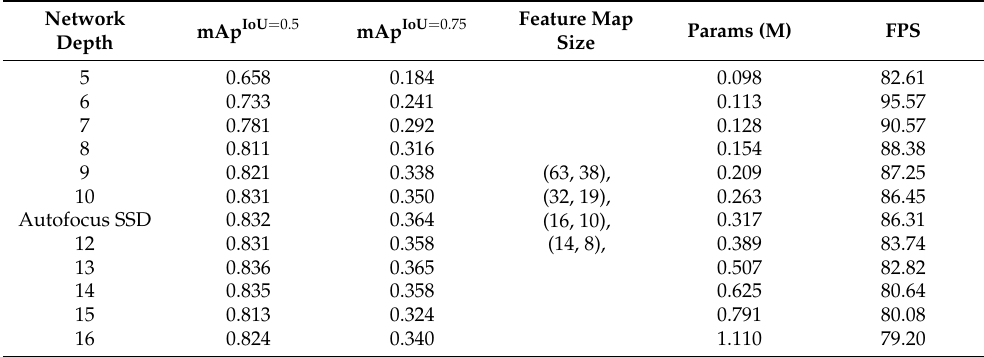
Table 6. Relationship between depth and Autofocus SSD prediction performance in Modified Table 7. Relationship between depth and Autofocus SSD prediction performance in Original MobileNetV2 group.